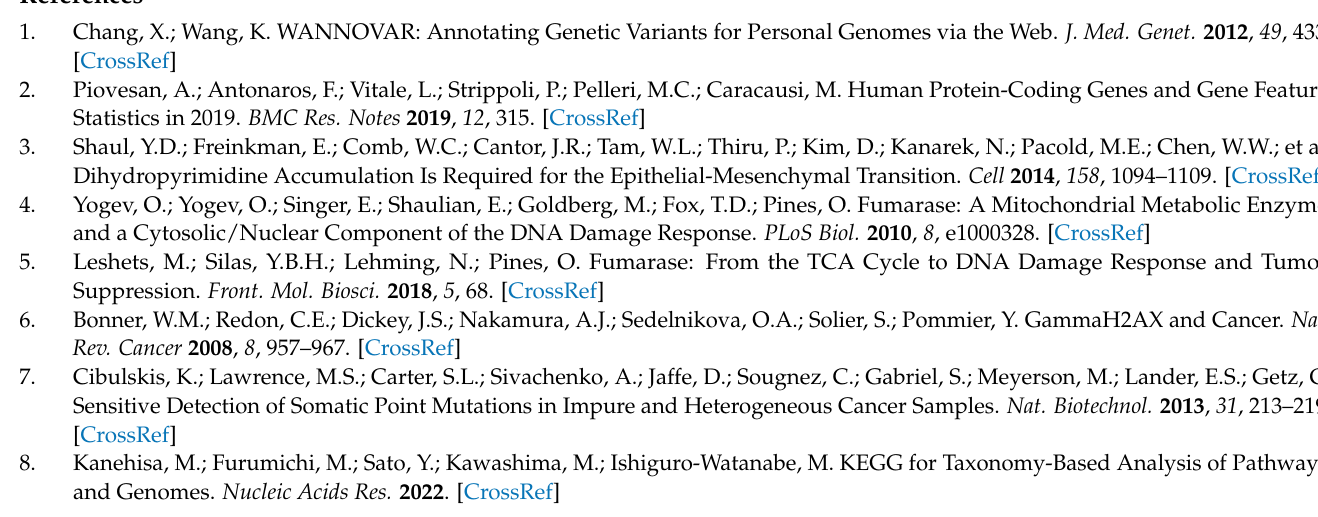
mutations are enriched in signaling genes; Figure S4: Uncropped Western Blots of blots shown in Figure 1; Figure S5: Uncropped Western Blots of blots shown in Figure 2; Figure S6: Uncropped Western Blots of blots shown in Figure 5; Figure S7: Uncropped Western Blots of blots shown in Figures S1 and